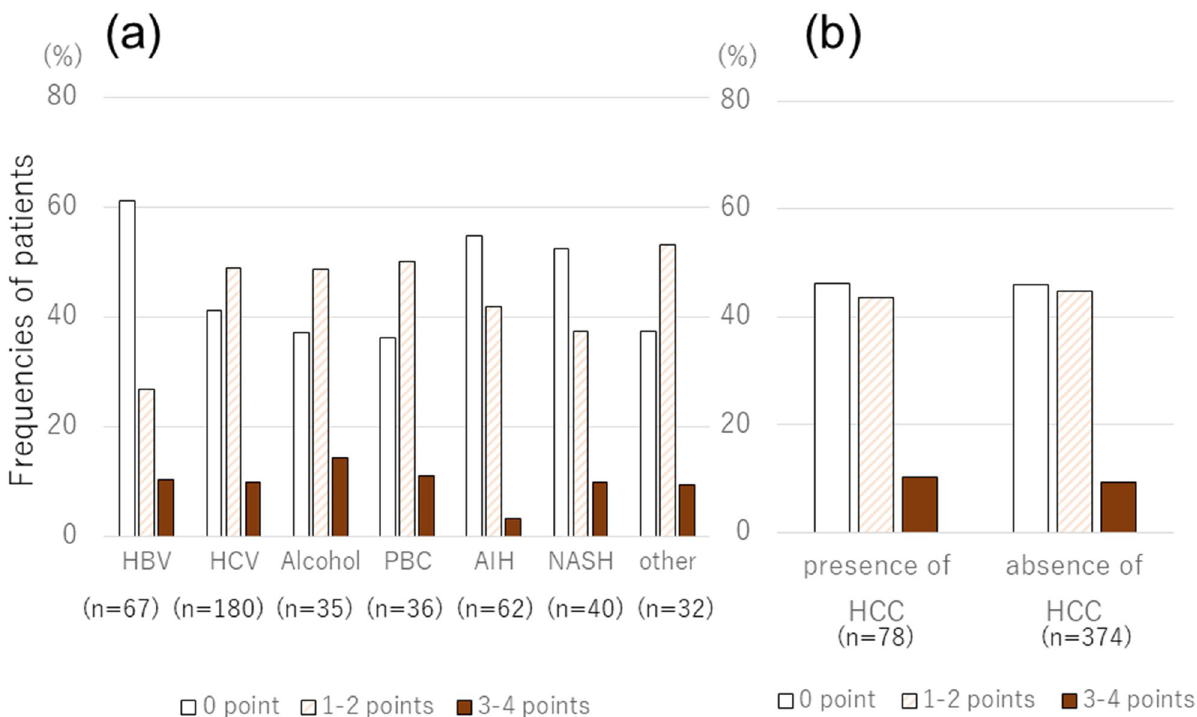
Figure 1. ( a ) The distribution of pruritus scores is shown, according to the etiology of chronic liver disease. HBsAg-negative status ( P = 0.004) as factors significantly associated with pruritus in multivariate analysis. Severity of pruritus scores was not significantly different between diseases. ( b ) The distribution of pruritus scores is shown, according to the presence of hepatocellular carcinoma (HCC). There was no significant difference in the incidence or degree of pruritus regarding the presence or absence of